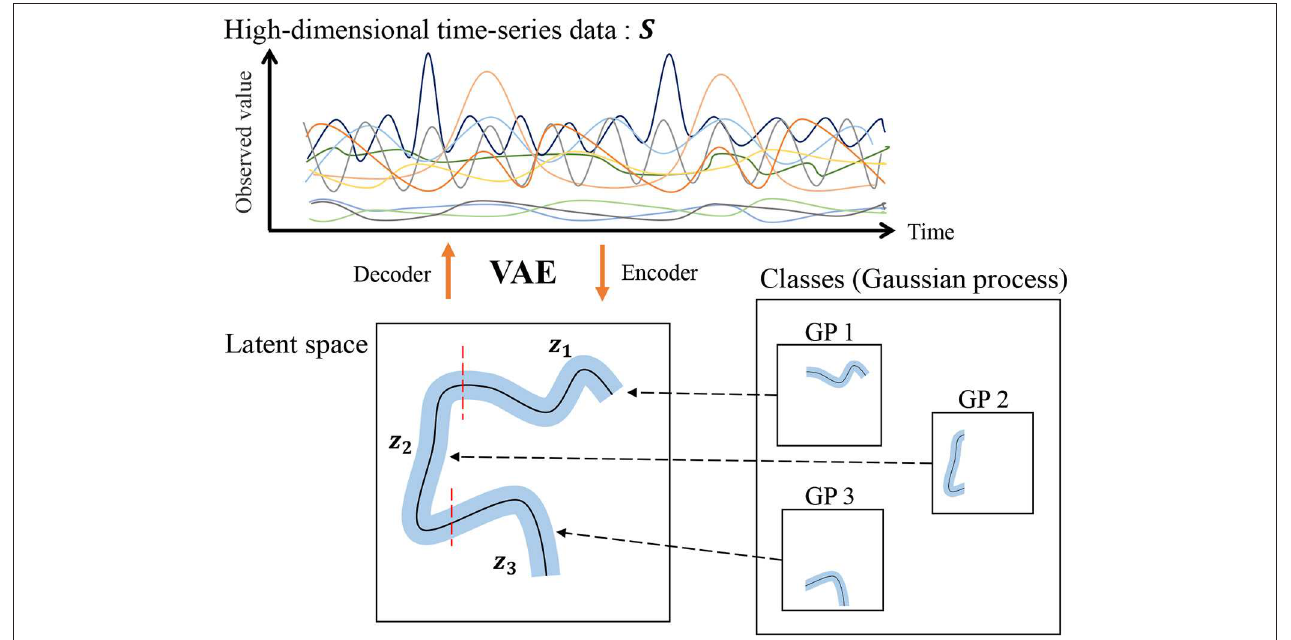
FIGURE 1 | Overview of the generative process of the HVGH.